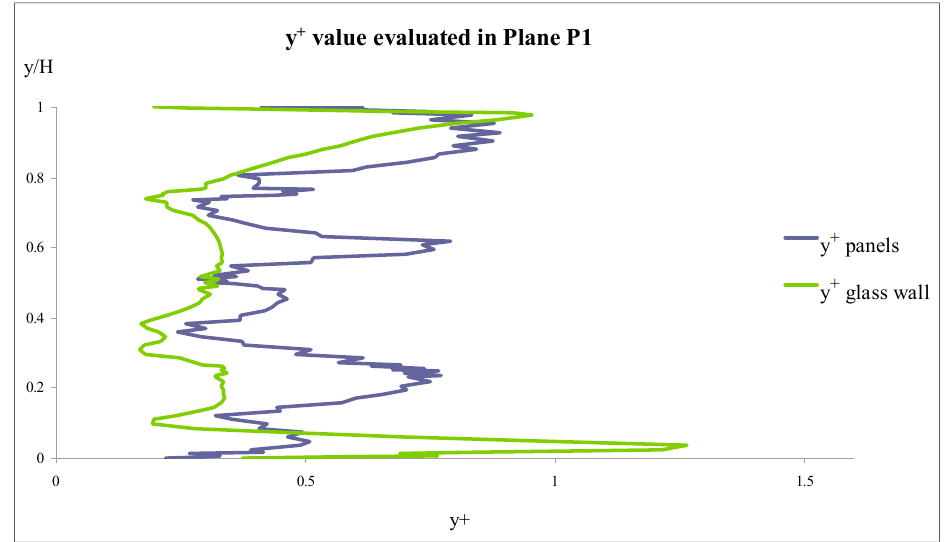
Figure 8. Boundary layers y + values evaluated on the inner and outer layers of the ventilated air cavity.